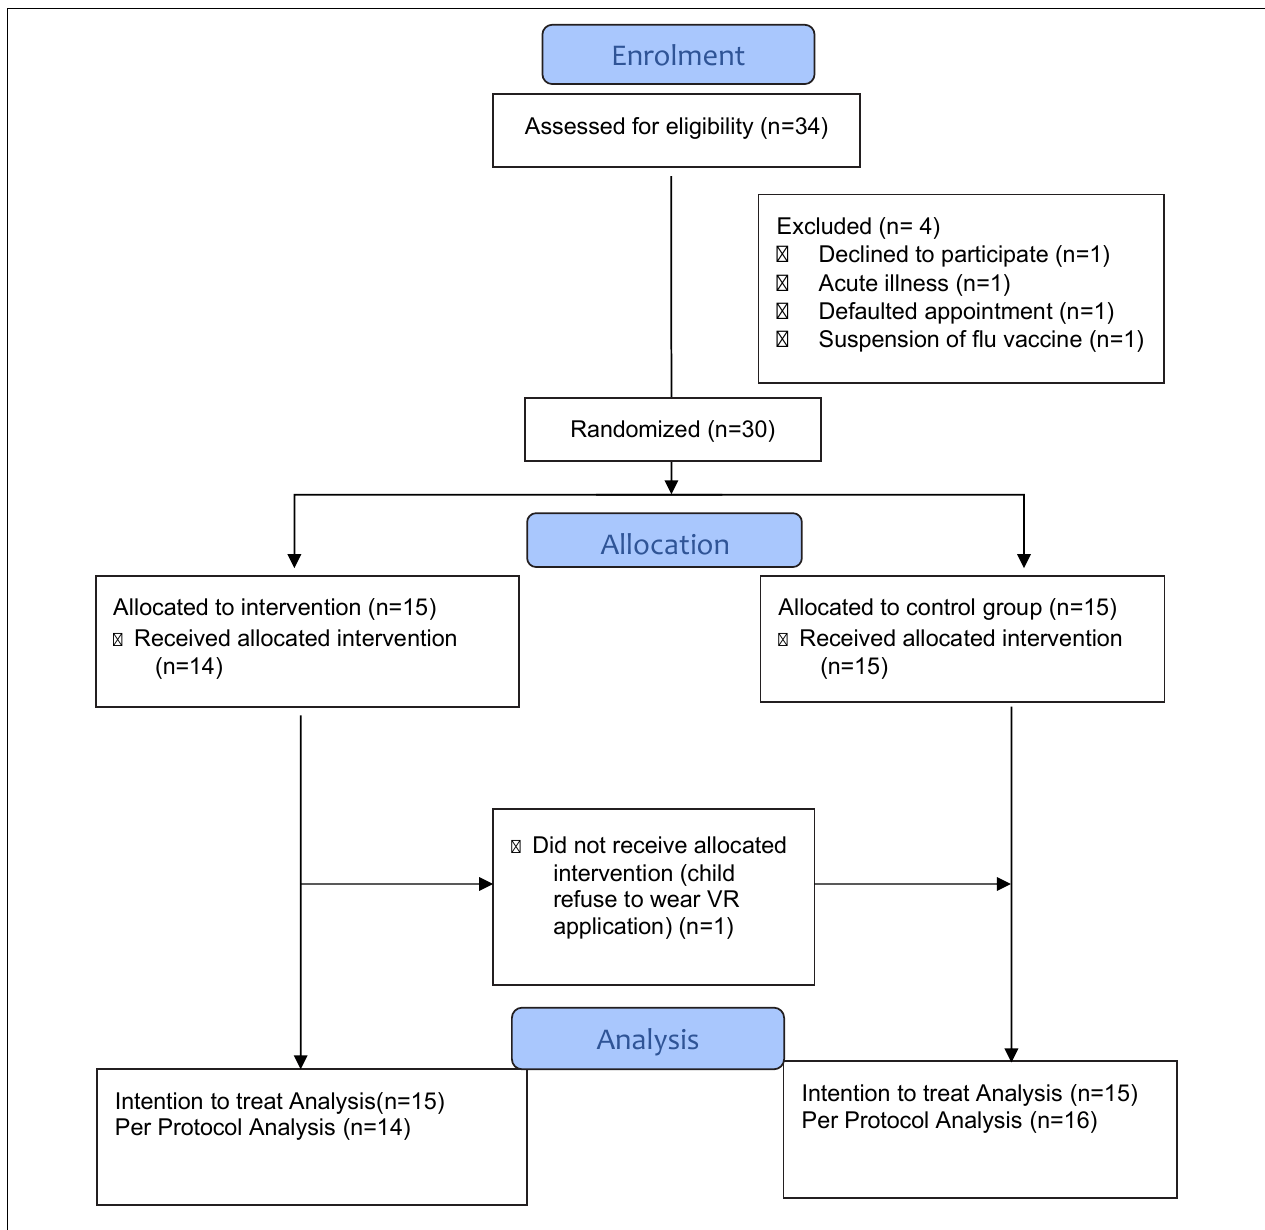
FIGURE 2 | CONSORT (Consolidated Standards of Reporting Trial) flow diagram of